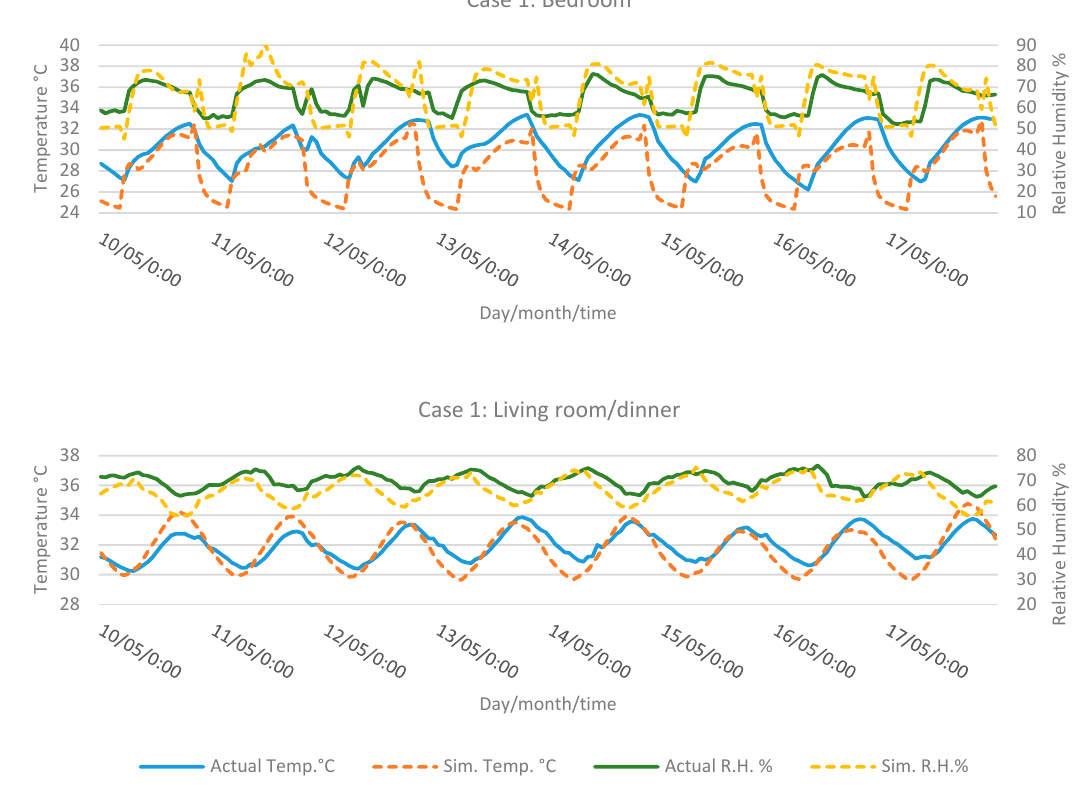
Figure 5. Graphical temperature and relative humidity comparison between actual and simulated data in each zone for Case 1.